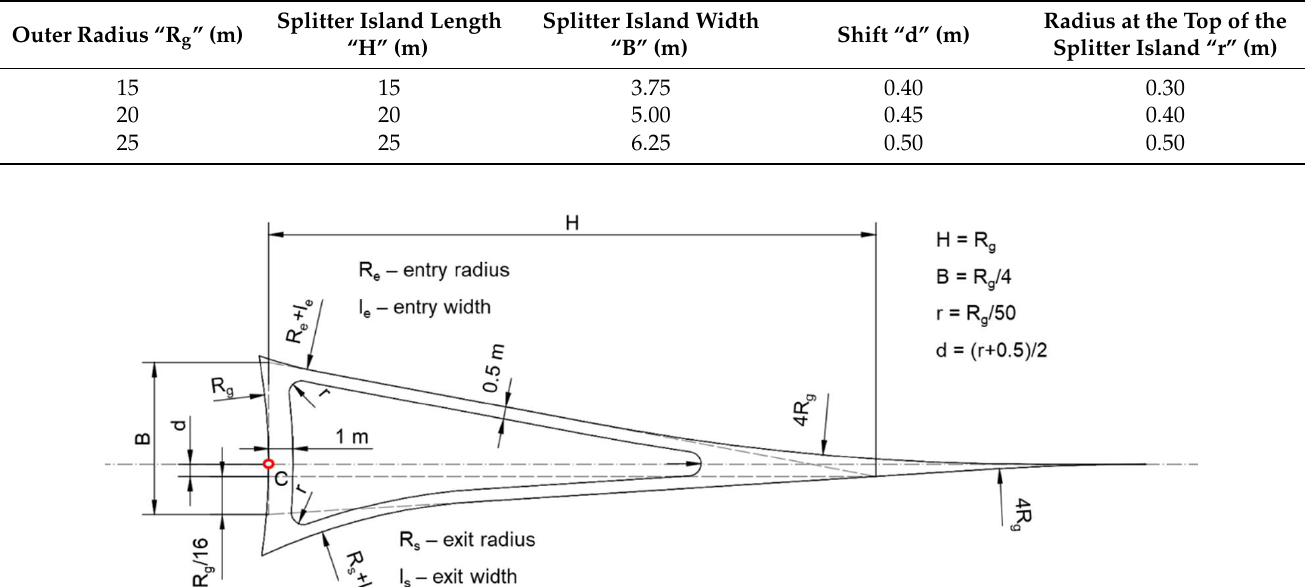
Figure 12. Splitter island elements according to [6]. The center point at the top of the island (point C) is represented by the red circle. Table 4. Splitter island elements according to [6].